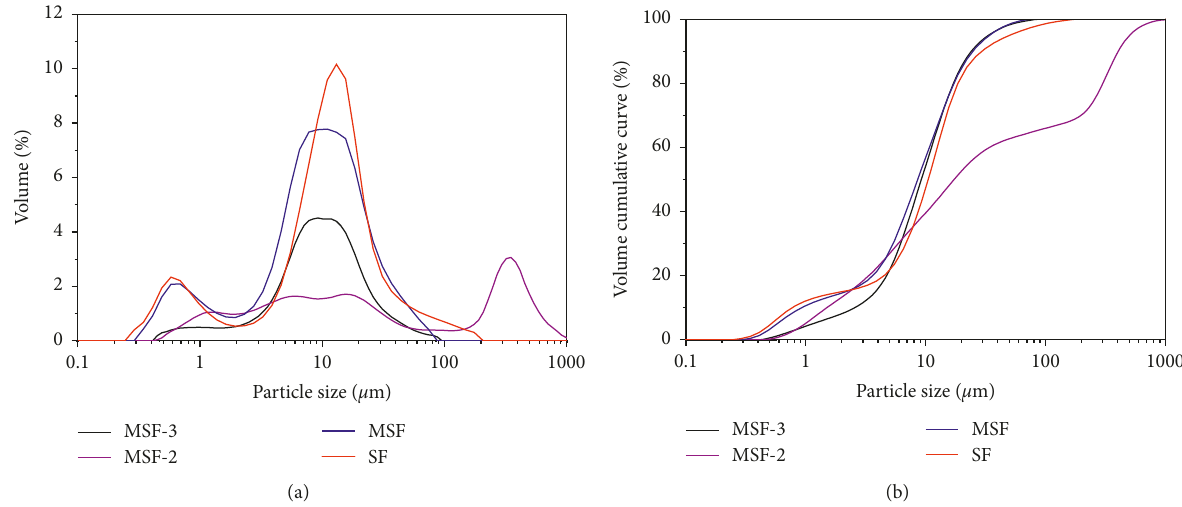
Figure 3: Particle size distribution (a) and cumulative curve (b) for samples with different dosages of the modified